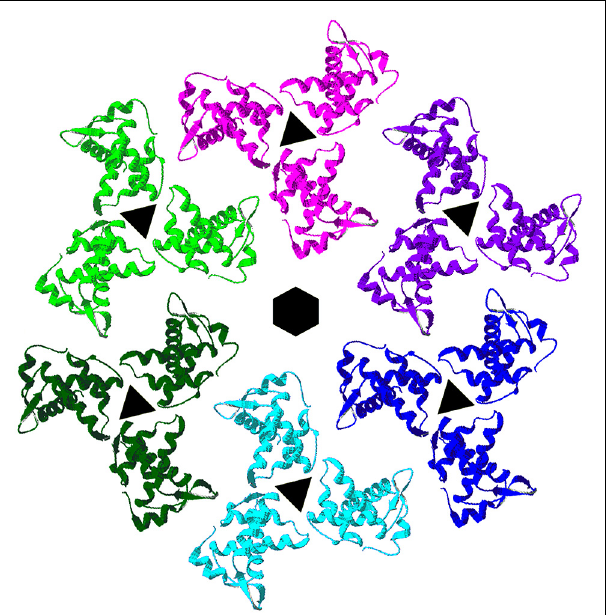
FIGURE 2 | Membrane organization of HIV-1 matrix proteins. Trimers of HIV-1 matrix proteins (PDB 1HIW) were fitted onto the electron densities of HIV-1 MA proteins assembled onto a lipid monolayer containing PI(4,5)P2 (Alfadhli etal., 2009a). As shown, trimers organize in hexameric rings around protein-free holes. MA residues that have been shown to affect HIV-1 Env protein assembly into virions locate toward the centers of the hexameric holes, implying that the cytoplasmic tails of HIV-1 Env proteins occupy these spaces.